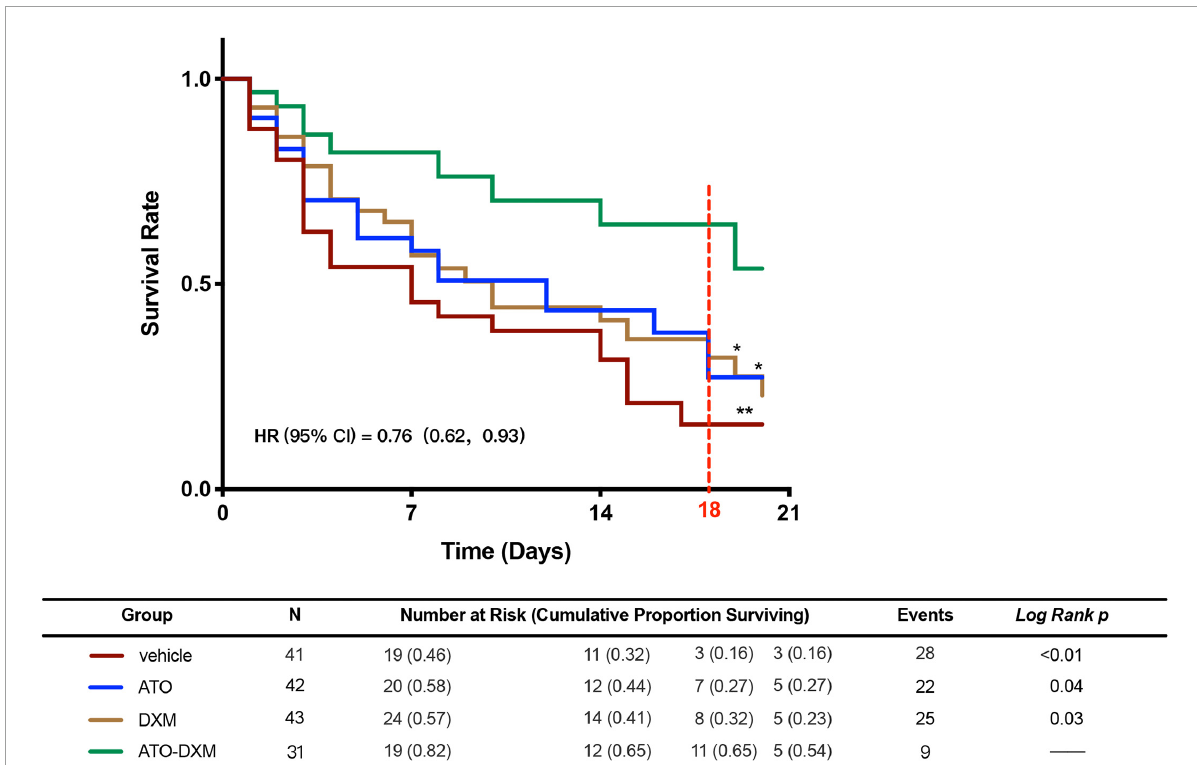
FIGURE2 ATO-DXM treatment improves the survival rate of ICH mice. Kaplan–Meier Survival Curves were plotted for each group of ICH mice. Compared to the vehicle group, ATO treatment, DXM treatment, and ATO-DXM treatment significantly increased the survival rate. Compared to monotherapy, the combination of ATO and DXM treatment considerably improved the survival rate at day 18 after ICH. * Log-Rank p < 0.05; ** Log-Rank p <